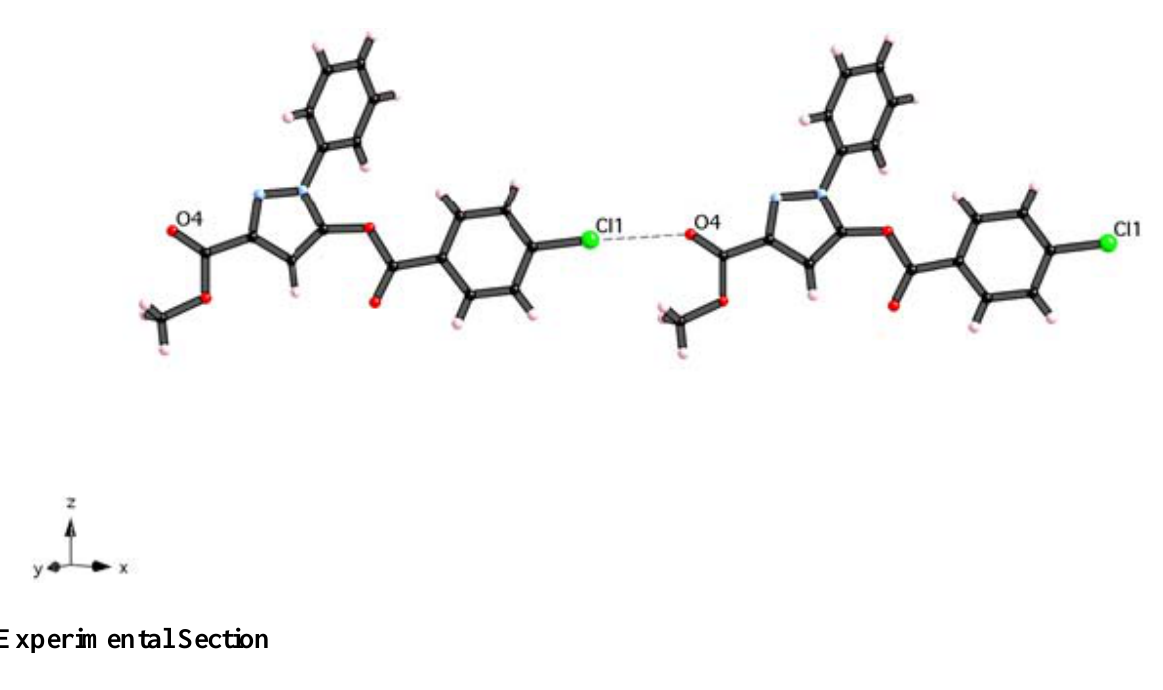
Figure 4. Chlorine–Oxygen σ -hole